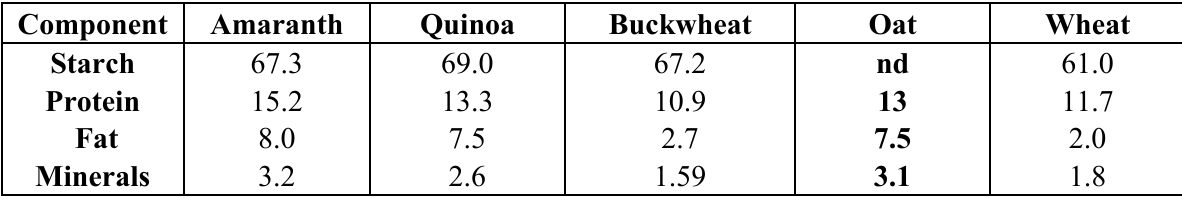
Table 5. Chemical composition (% dry mass) of Amaranth, Quinoa, Oat and Buckwheat compared to Wheat.